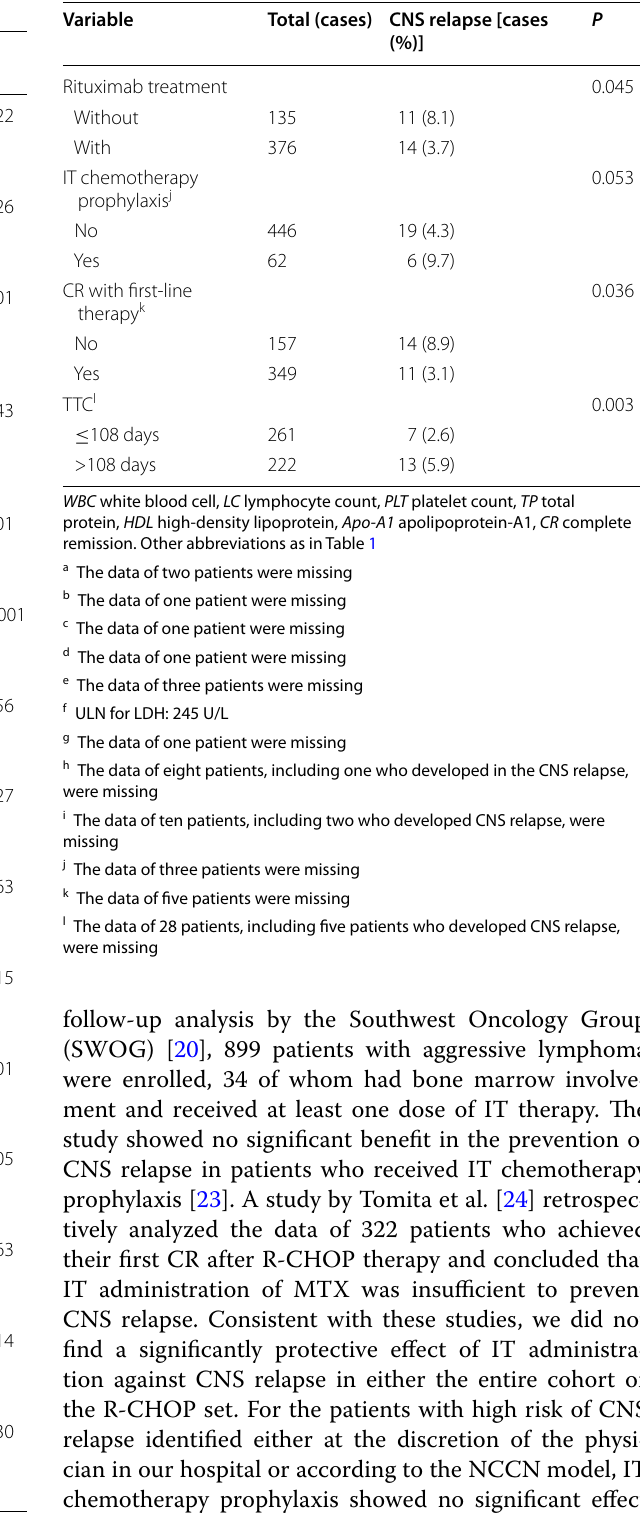
Table 2 Univariate analysis of risk factors for CNS